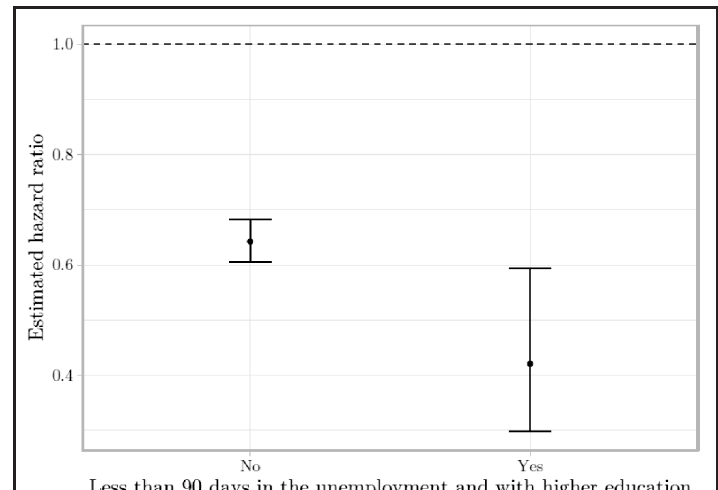
Heterogeneous effects: potentially bogus